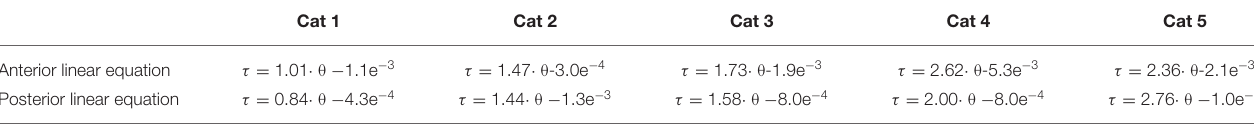
TABLE 2 | Average linear regression equations for each category for both the anterior and posterior directions.